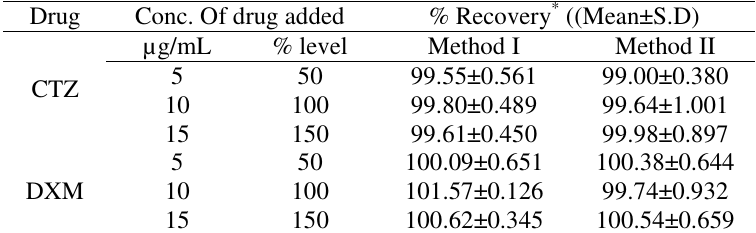
Table 3. Recovery studies of CTZ and